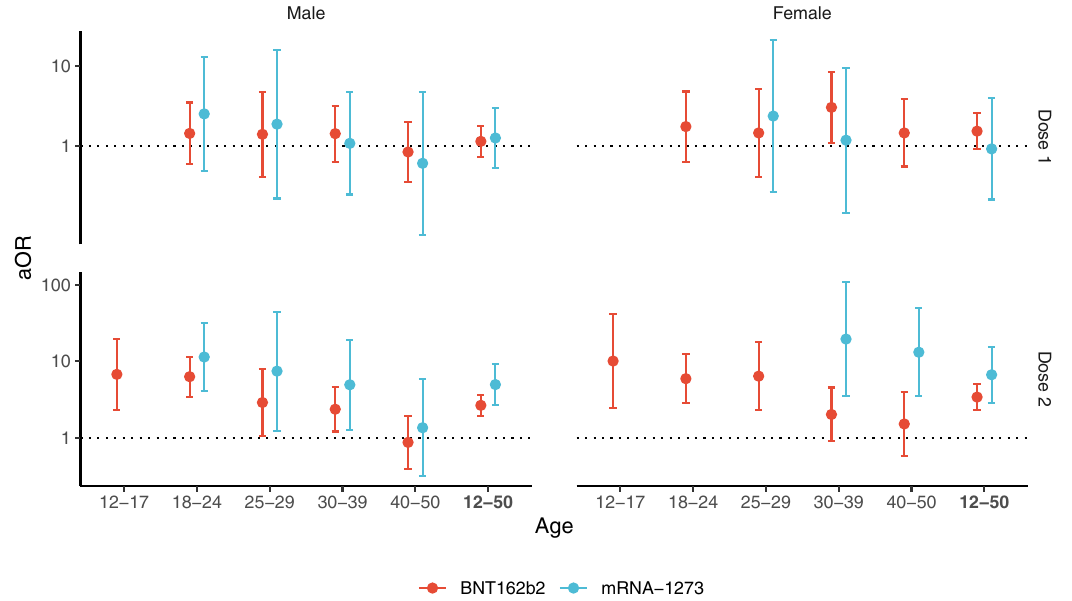
Fig. 2 Association between pericarditis and exposure to mRNA vaccines within 7 days, according to sex and age group. Adjusted odds-ratio (aOR) from multivariable model are represented in base 10 logarithmic scale according to age groups ( x -axis), by sex (columns) and vaccine dose ranking (rows). Colors denote the type of vaccine. Centre value are aOR point estimates and error bars represent 95% con fi dence intervals. Number of cases (N) by age categories (12 – 17, 18 – 24, 25 – 29, 30 – 39, 40 – 50 and 12 – 50 years) are respectively as follows: N = 65, 194, 106, 282, 342 and 989 for males, and N = 36, 118, 91, 183, 196 and 624 for females. aOR could not be calculated in categories where no case exposed to vaccine was recorded, for instance for males and females aged 12 to 17 years having received the mRNA-1273